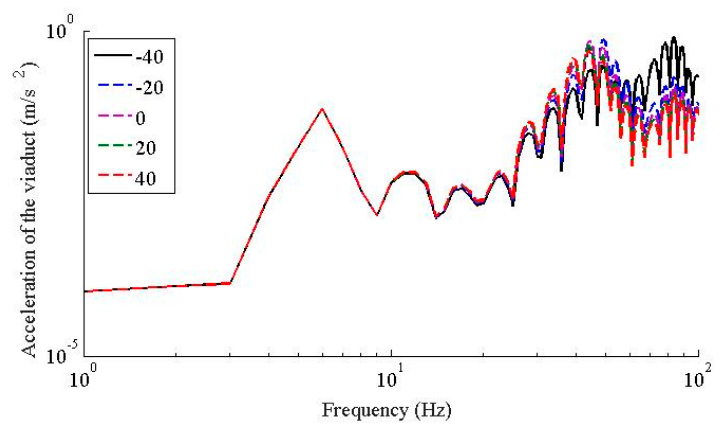
Figure 14. Vertical acceleration of viaduct under − 40, − 20, 0, 20, and 40 °C.